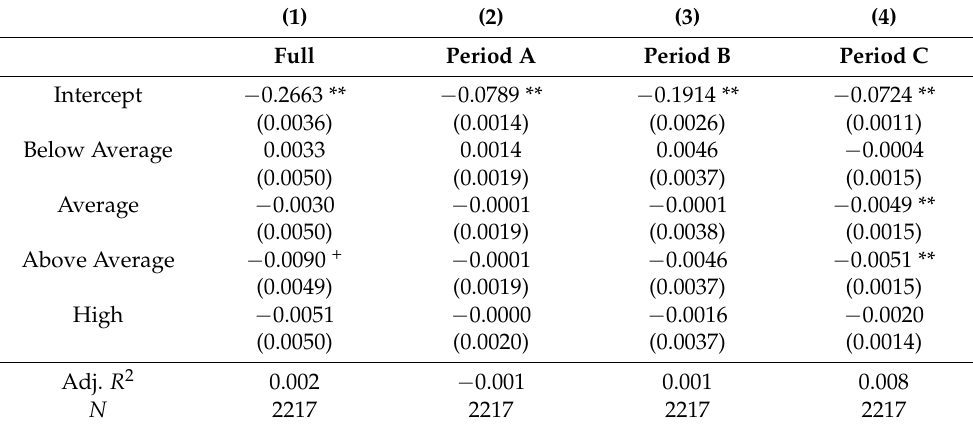
Table 8. Fee Level Drawdown